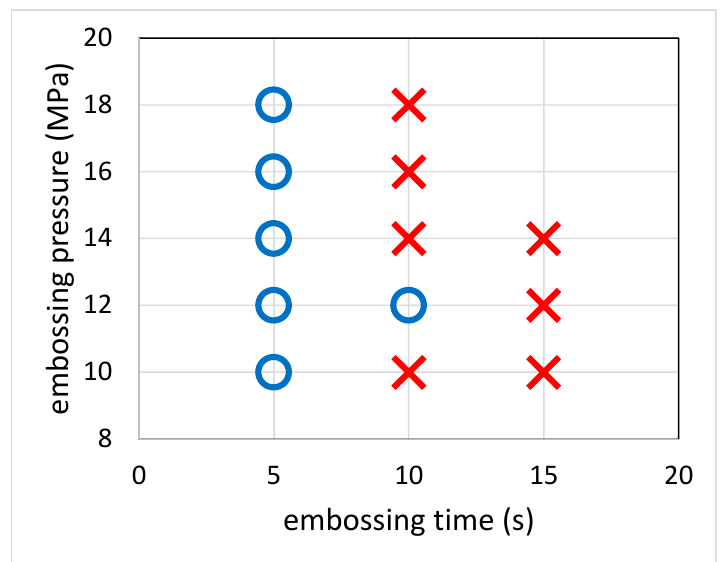
Figure 6. Effect of embossing pressure and embossing time on the process. The symbol “circle” refers to successful channel formation while the symbol “cross” refers to channel blockage.